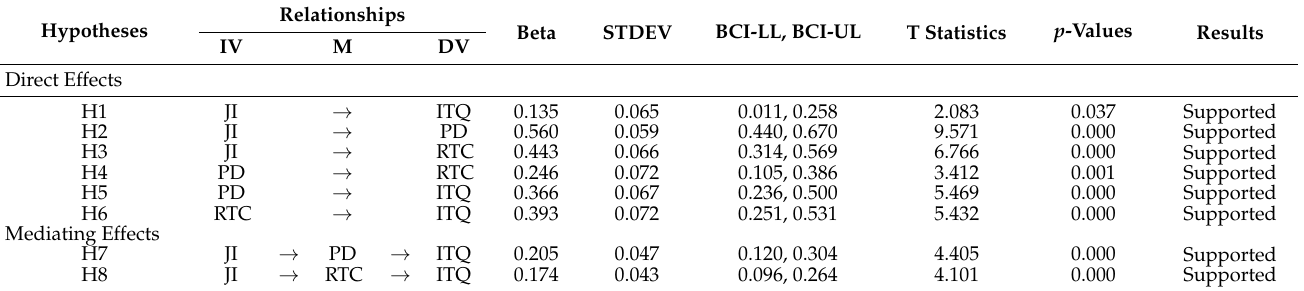
Table 6. Hypothesis results.